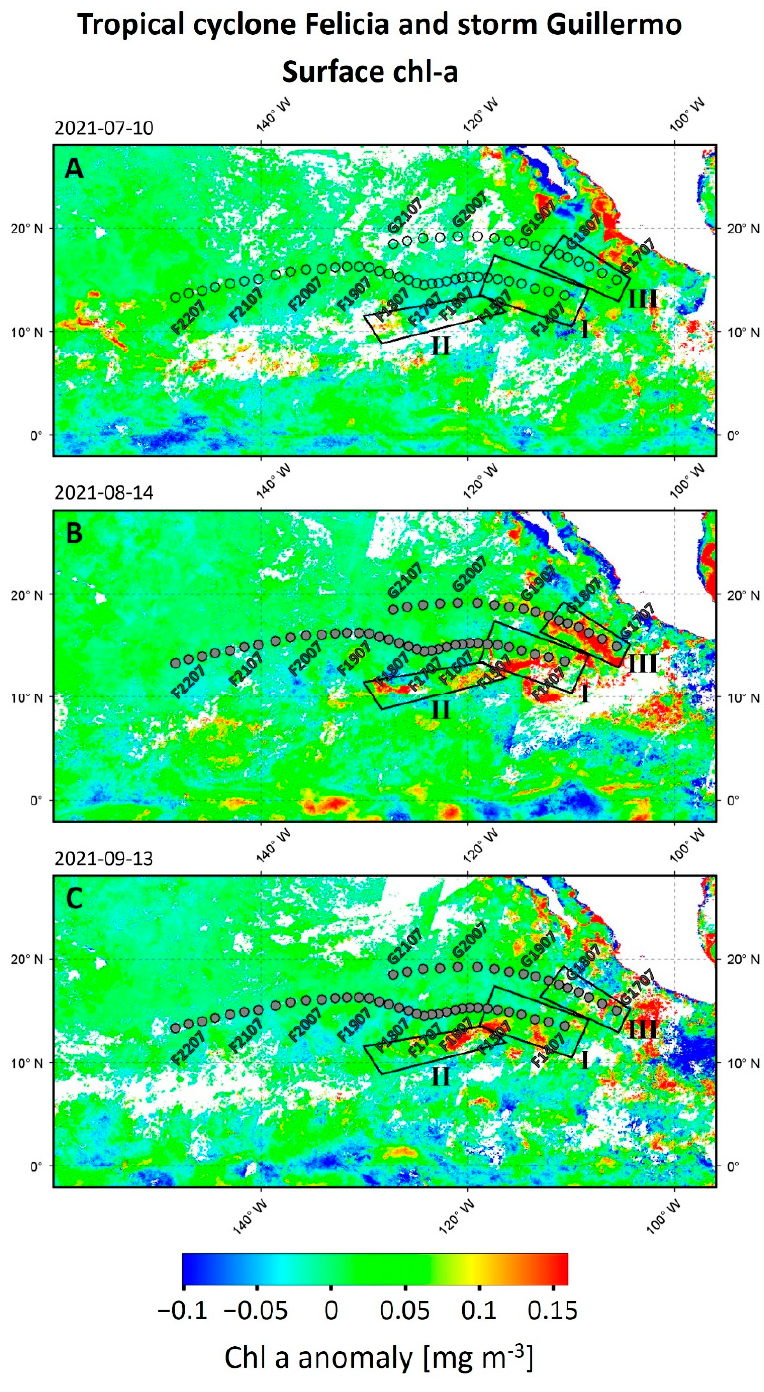
Figure 6. Anomaly maps for surface chl-a in the study area of TC Felicia and tropical storm Guillermo for ( A ) 10 July 2021, ( B ) 14 August 2021 and ( C ) 13 September 2021. Anomalies are color-coded as indicated by the color bar. Tracks are marked with circles. Open circles indicate that the storm has not yet passed the position. The labels along the track indicate position of TC Felicia (F) and storm Guillermo (G) on a particular day and month, e.g., F1407 or G1707. The dates of satellite images are given on the top left of each panel. Note that surface chl-a data were obtained as 5-day means (see Methods). White space indicates areas without data.